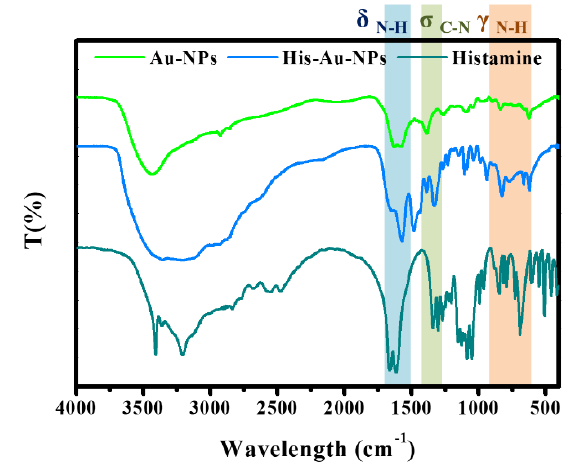
Figure 1. FTIR of Gold nanoparticles (Au-NPs) and the aggregation of histamine-Au-NPs.